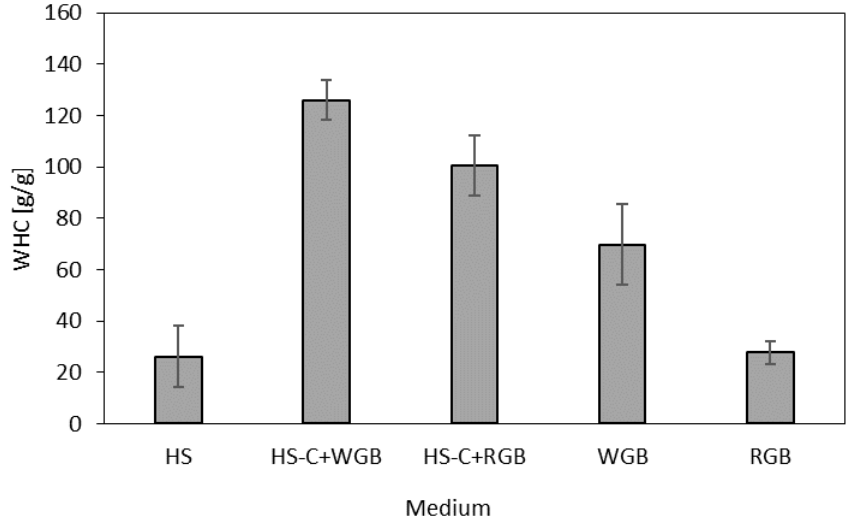
Figure 4. Water-holding capacity (g/g) of BC produced in different culture media.